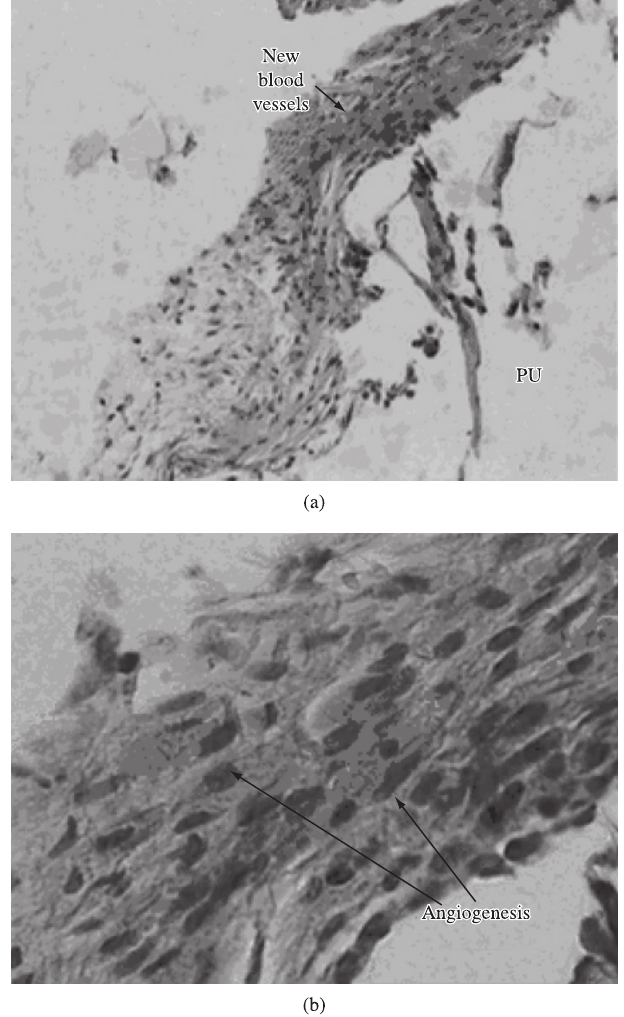
Figure 9. Optical micrographs of tissues grown close to the surface of the polyurethane nanocomposite. a) Histological evaluation after 14 days (magnification 10×) and b) accentuated angiogenesis process (magnification 40×)